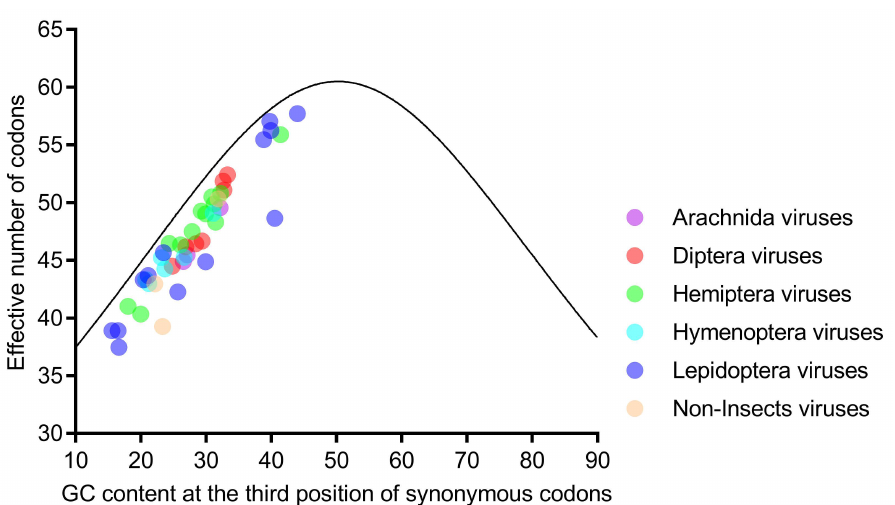
Figure 4. All genomes of the six host-taxa-groups interspersed and aligned along, but not on, the expected curve in the ENc (e ff ective number of codons)-plot analysis, indicating that the factors influencing the codon usage in the six host-taxa-groups are similar, and mutation is not the main force. Each dot represents a viral genome corresponding to the two coordinate axes. The solid curve indicates the expected ENc values, assuming that the GC compositional constraints alone account for the codon usage.